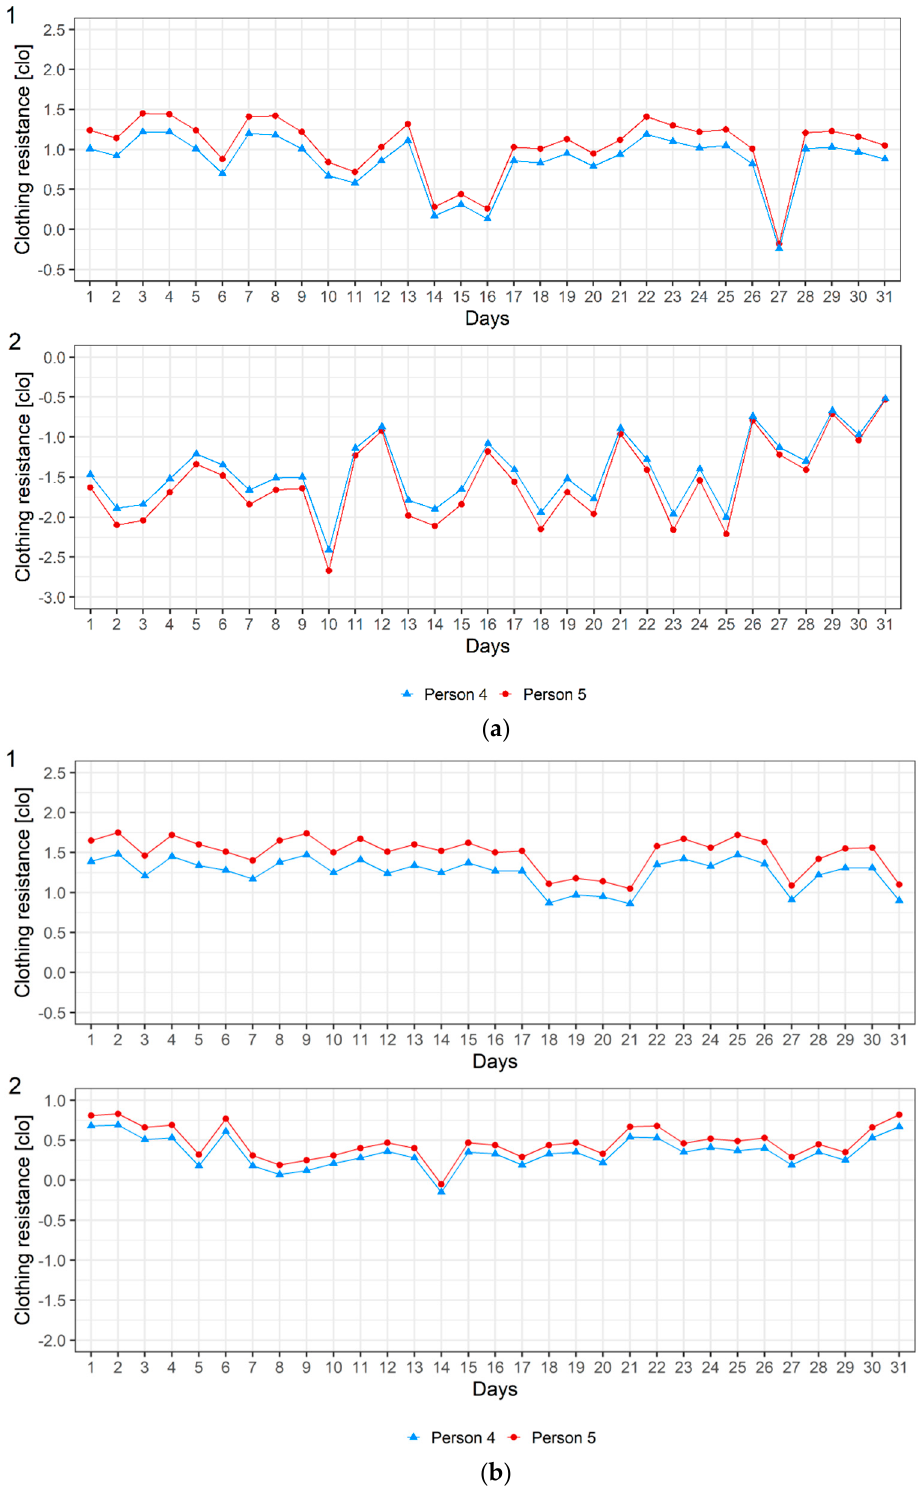
Figure 4 . ( a ) Evolution of the thermal load at noon (12 UTC) for humans 4 and 5 over 31-day winter ( 1 ) and summer ( 2 ) season periods in the city of Sopron; ( b ) Evolution of the thermal load in the early morning (4–6 UTC) for humans 4 and 5 over 31-day winter ( 1 ) and summer ( 2 ) season periods in the city of Sopron. The main difference between them is in their radiation and wind speed conditions. When the thermal load is strong ( r cl is − 2.5 clo or lower), global radiation is very high